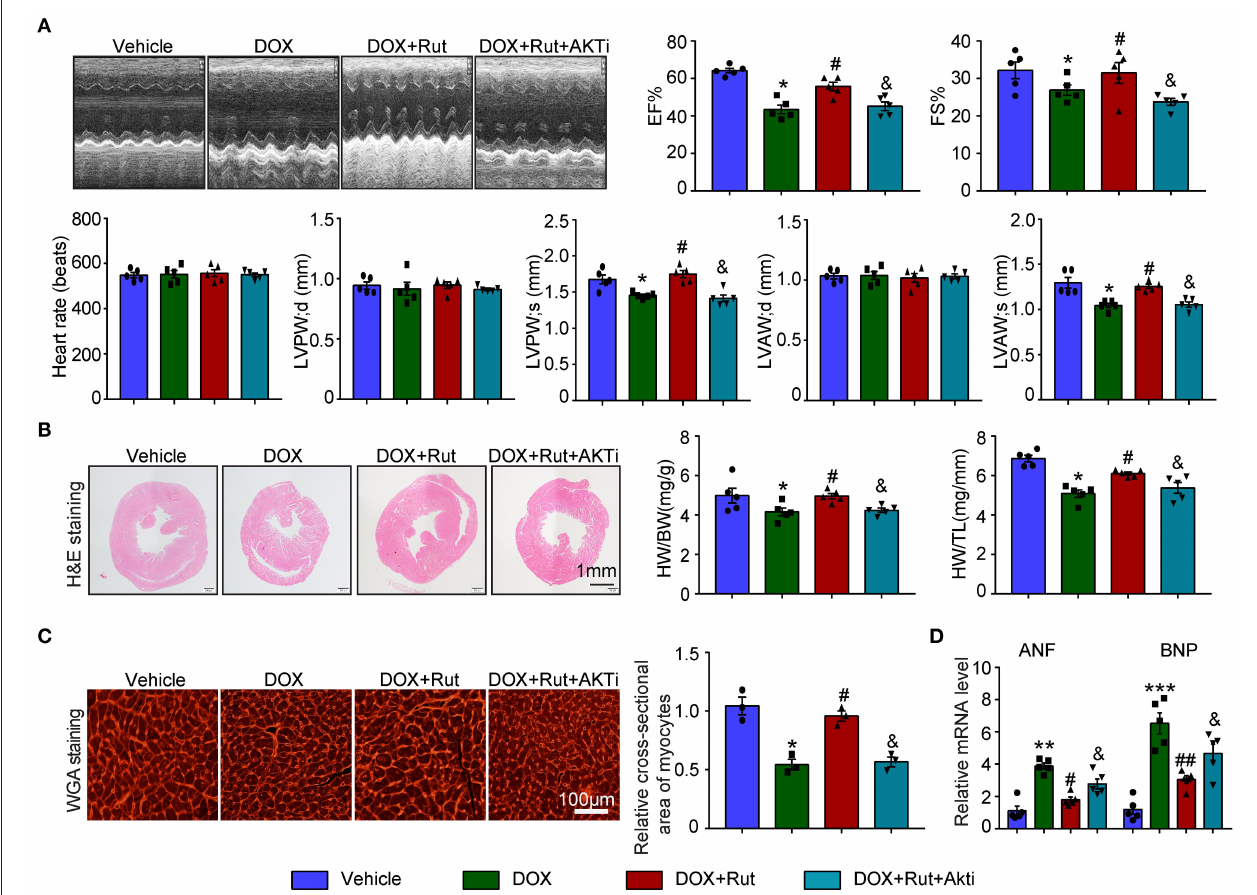
FIGURE 6 | AKT inhibitor alleviated the cardio-protective effect of rutaecarpine on DOX-induced heart failure. Mice were intraperitoneally injected with AKTi (20 mg/kg) every other day for 4 weeks from the first day before DOX and Rut administration. (A) Representative M-model echocardiography of the left ventricular EF% and FS%. The heart rate, LVPW, and LVAW at diastole and systole were shown below ( n = 5). (B) Representative image of HandE staining and the HW/BW and HW/TL ratios (right, n = 5). Scale bar 1mm. (C) Cardiac myocyte size was evaluated by TRITC-labeled WGA staining, and the cross-sectional area was quantified in the right panel (100 cells counted per heart) ( n = 3, right). Scale bar 100 µ m. (D) ANF and BNP mRNA expressions were determined by qRT-PCR in the heart ( n = 5). * p < 0.05, ** p < 0.01, *** p < 0.001 vs. vehicle; # p < 0.05, ## p < 0.01 vs. DOX group; & p < 0.05 vs. DOX plus Rut